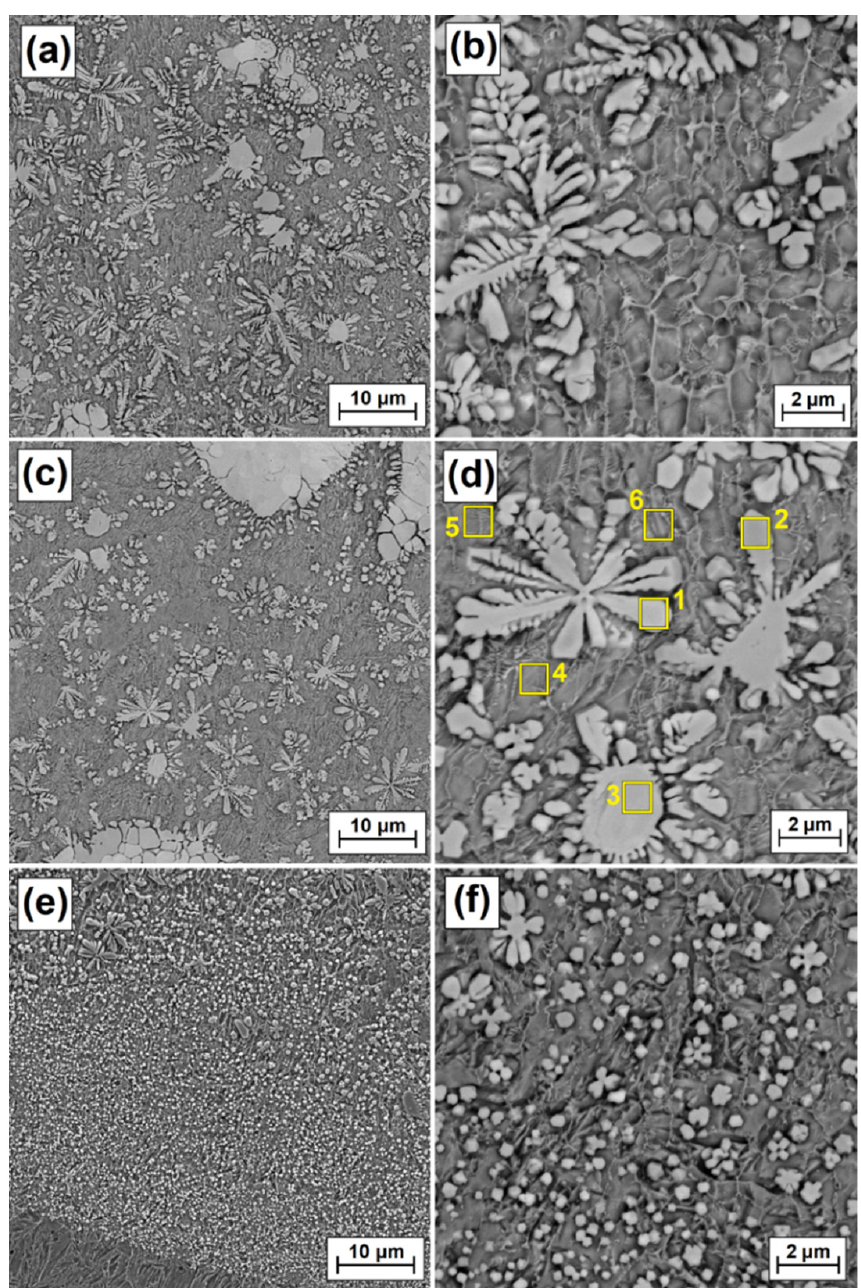
Figure 6. Melted zone microstructure of Fe/ZrC coatings produced using a laser beam power of 500 W; subsurface area ( a ), magnification of subsurface area ( b ), middle area ( c ), magnification of middle area ( d ), sub-substrate area ( e ), magnification sub-substrate area ( f ) .